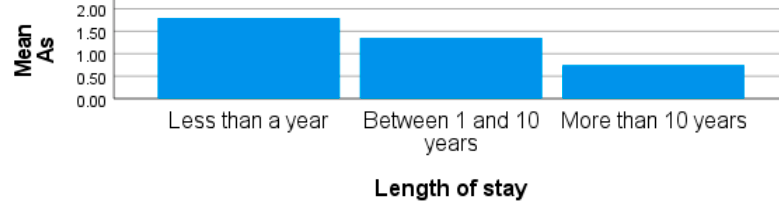
Figure 4. Showing blood As for length of stay in obese females living around site 3. From site 2, the mean blood Pb concentration was higher than those recorded for participants from sites 1 and 3 with a mean, standard deviation and range of 19.41 ± 11.84 µ g/L (6.70–60.20 µ g/L). The concentration of Pb from site 1 was also higher than the recommended limit of 0.80 µ g/L, with a mean of 6.70 ± 3.40 µ g/L and a range of 5.00–18.40 µ g/L. mean blood Pb concentrations from some participants from site 3 (0.51 ± 0.05 range